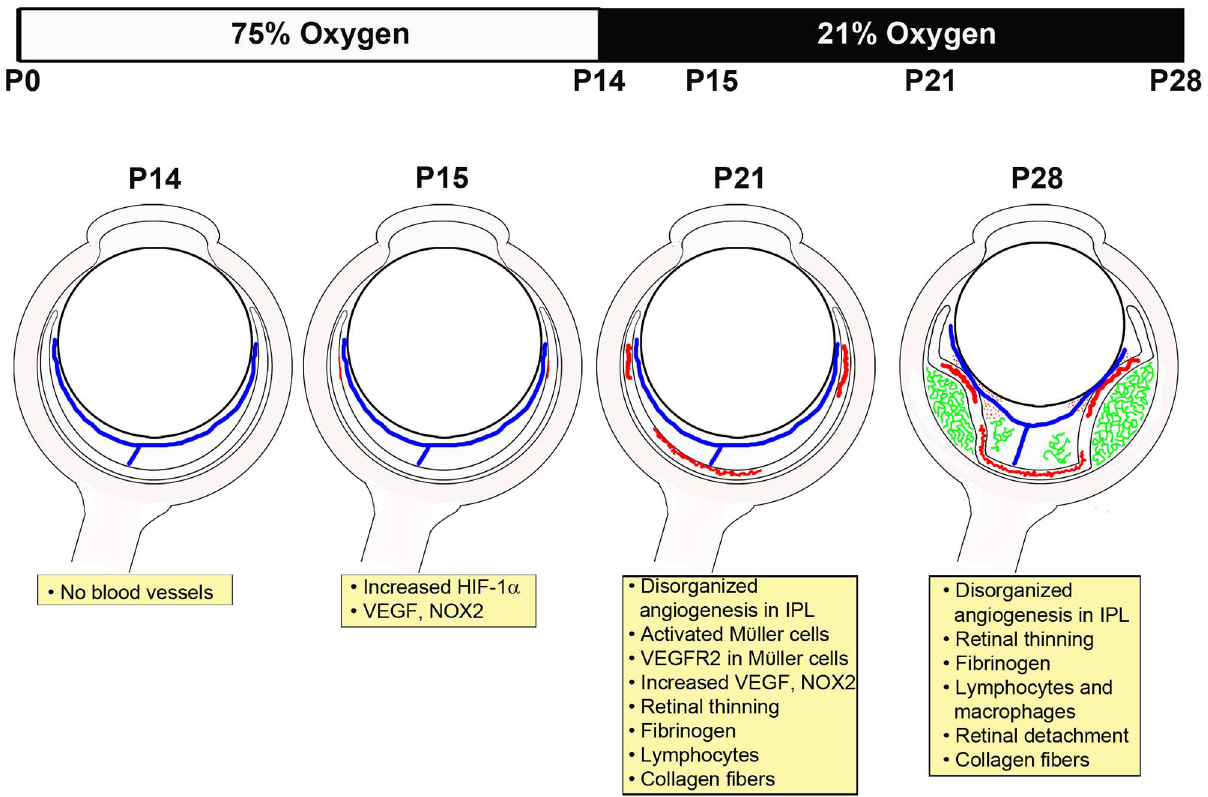
Fig 10. Schematic of downstream events in hyperoxia-induced proliferative retinopathy model. Upon removalfrom 75% oxygen at P14, there are no retinal vessels seen except for the persistent hyaloidalvessels (blue). By P15, the surge in HIF-1 α leads to an increase in VEGF and angiogenesis(red) in the central retina and mid-periphery. At P21, there is disorganizedangiogenesis (red) in the IPL and increasedVEGF and NOX2. Fibrinogenand CD45+ lymphocytes are observedin the retina. By P28, the retina is thin and collagenfibers were detected in the vitreous, indicatingtraction retinal detachment. Fibrinogen (green) was found in the vitreous and sub-retinal space (suggestiveof exudativedetachment)and hemorrhages were seen in the vitreous (red dots). CD45+ lymphocytes and F4/80+ macrophages are increasedat